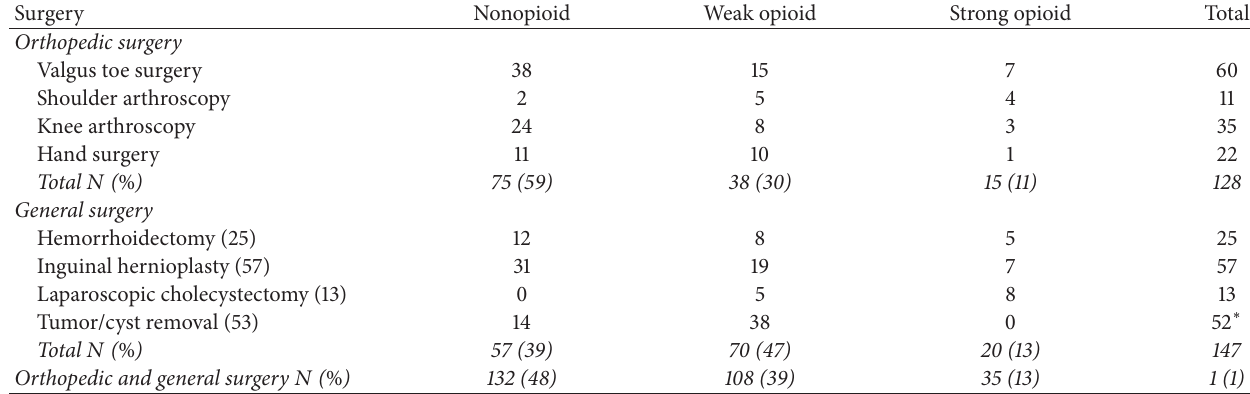
Table 3: Postoperative analgesia in recovery room by type of surgery.